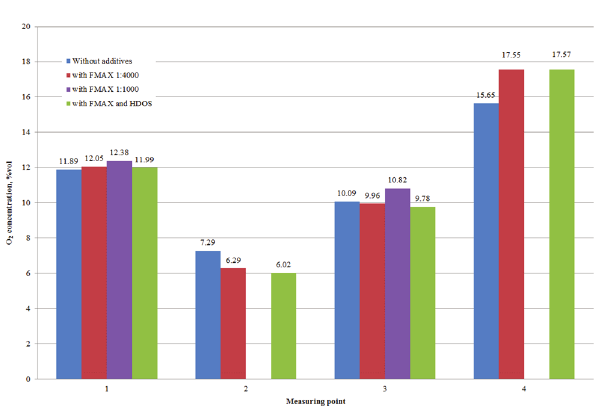
Fig. 6. Concentrations of CO 2 measured in tests